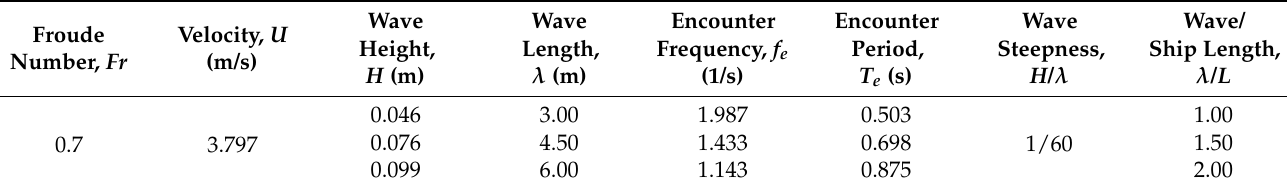
Table 2. Regular wave computations of Delft 372 catamaran: test matrix.